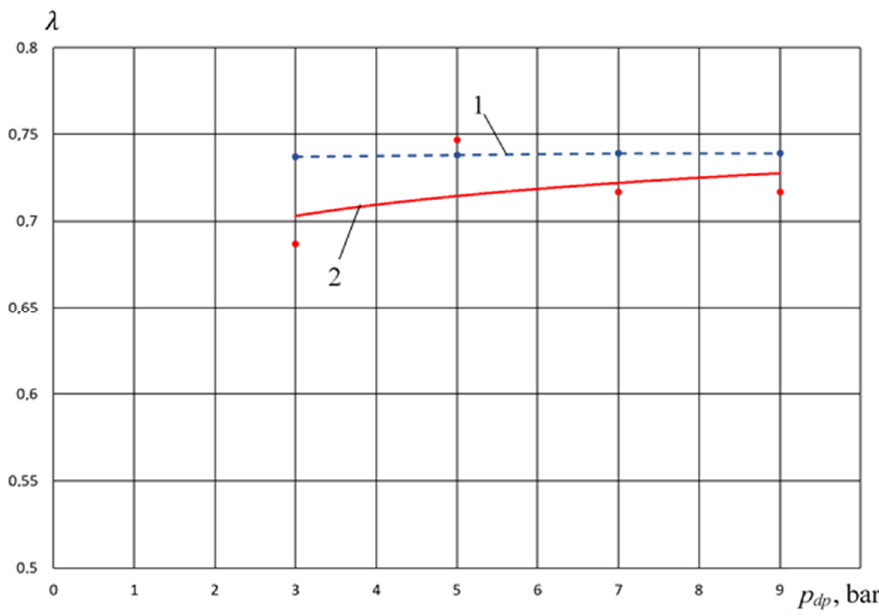
Figure 15. Dependence of the supply coefficient of the compressor section on the discharge pressure of the pump section (1—Theory; 2—Experiment).